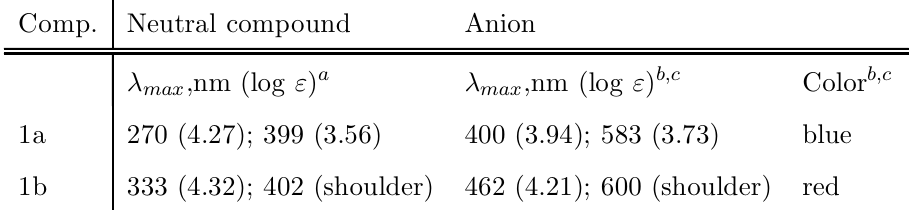
Table 4 Electronic absorption maxima of compounds 1a,b and their anions [2,14]. a In dichloromethane; b in dichloromethane as supramolecular complex with the crown ether 18-crown-6 and KOH for 1a [2]; c in methanol-water with NaOH (1 : 1, v/v) molar ratio 1 : 1 compound : NaOH [14]. potentiometric titration) of compounds 4a,b and 1a,b [1,2]. Comp.